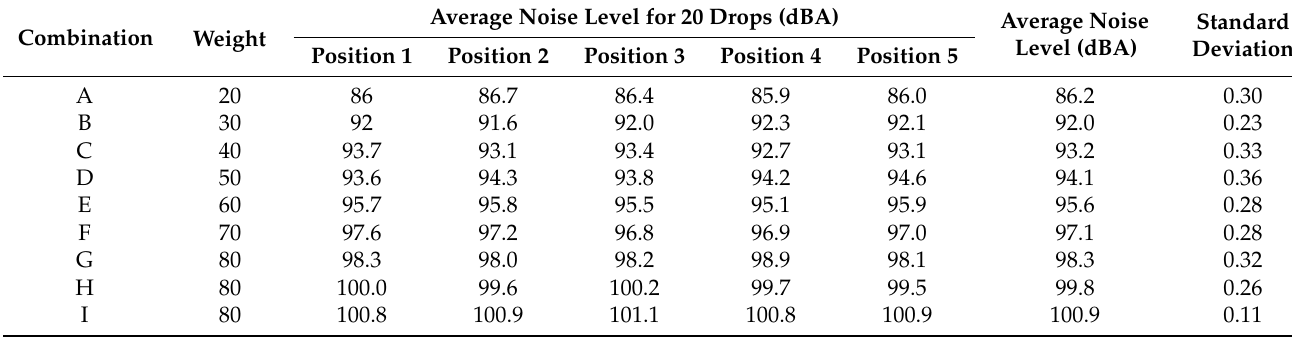
Table A3. Detailed data of four selected groups